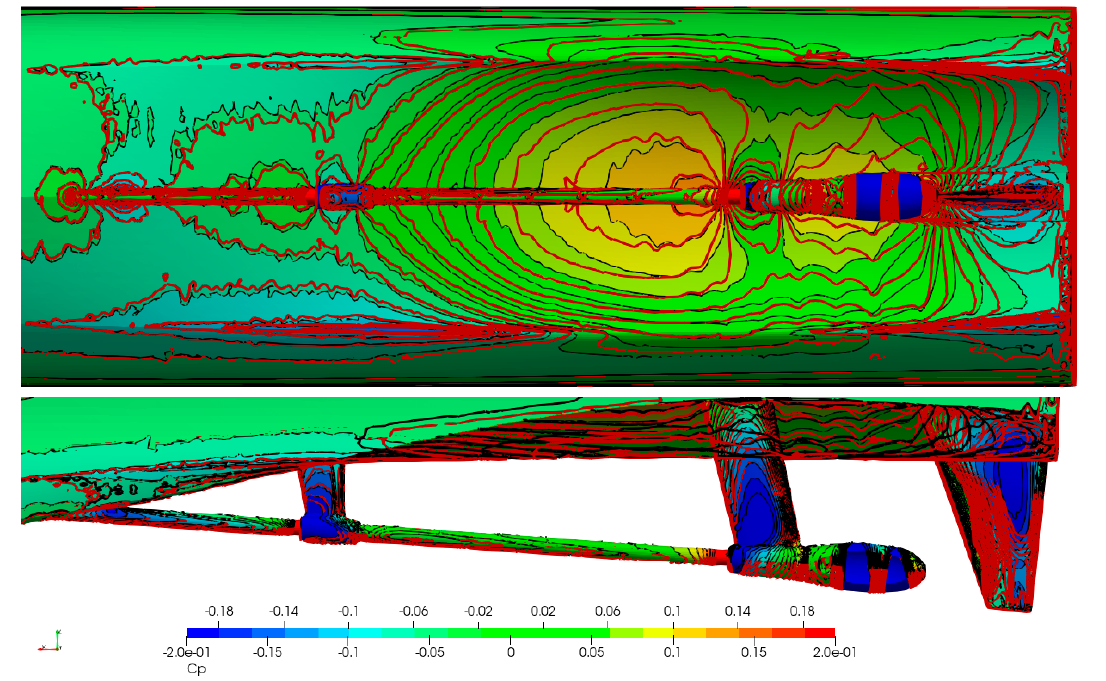
Figure 14. Isolines of computed pressure field in ship’s stern tunnel region for resistance (black isolines) and propulsion (red isolines) condition at 23 knots: view from bottom ( up ) and view from side ( down ). The computed nominal wake is presented in axial velocity contours and transversal velocity vectors in Figure 15, illustrating and confirming again the minimal wake fraction factor. The nominal axial wake is very homogeneous except for a small region close to 178 degrees, where the wake of the shaft bracket is visible.